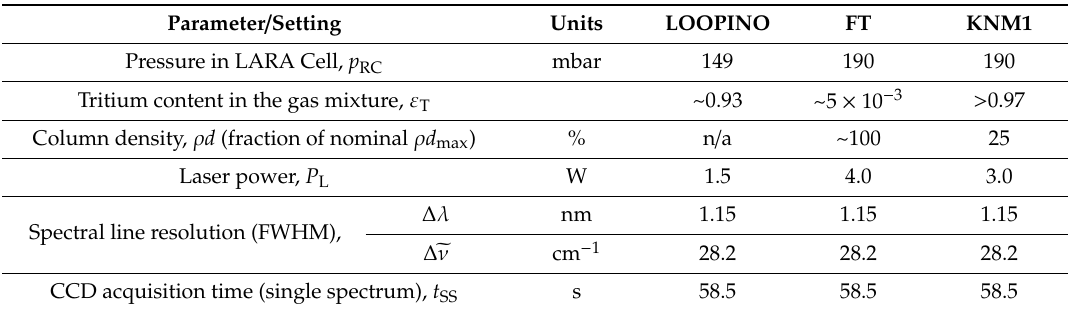
Table 2. Settings of key operating parameters for (i) LOOPINO-3—loop test measurements (without WGTS; unpublished results); (ii) FT—first tritium campaign, with reduced tritium content [21]; and (iii) KNM1—first KATRIN neutrino mass data taking